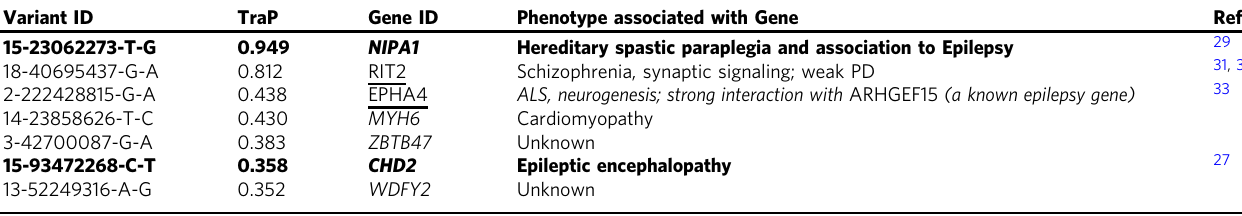
Table 1 Epi4K DNMs with high TraP scores Variant